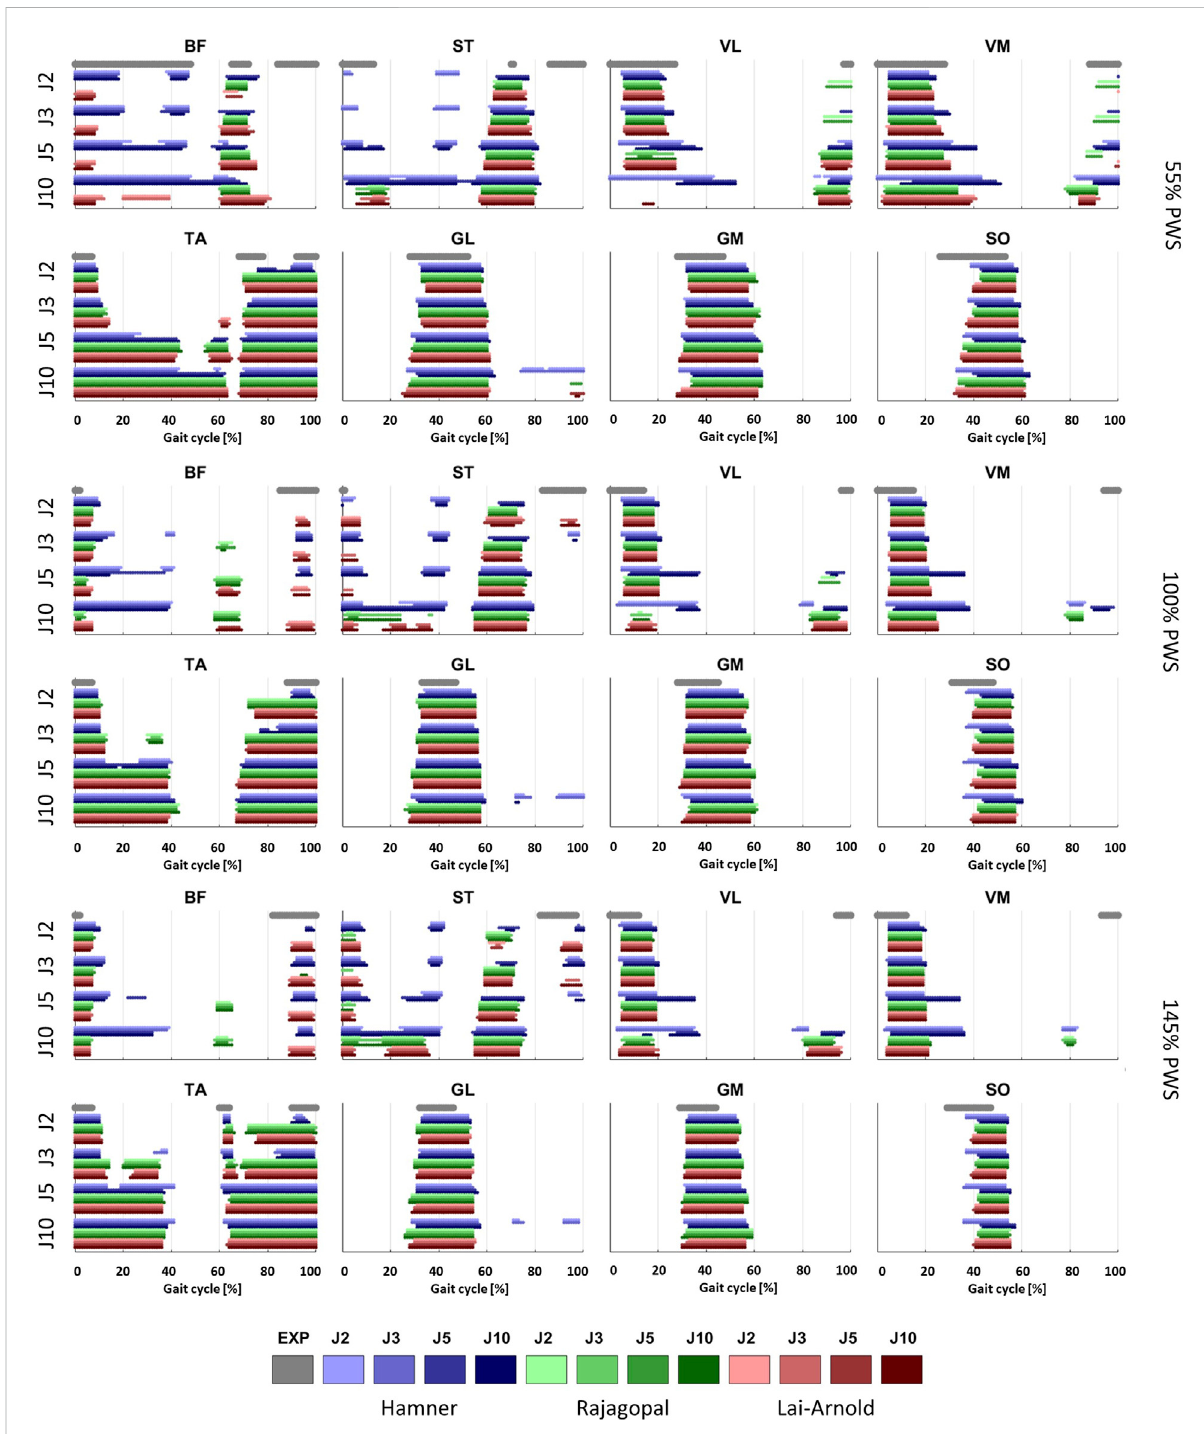
FIGURE 2 On/offtimingofEMGs,averagedoverallsubjects,andestimatedmuscleexcitationsof8musclesat3walkingspeeds,withperformancecriteria based on minimization of muscle effort to the power of 2 (J2), 3 (J3), 5 (J5) and 10 (J10), and scaling variants with linear scaling of OFL and TSL and generic MIF (S1), non-linear scaling of OFL and TSL and generic MIF (S2), linear scaling of OFL and TSL and scaled MIF (S3), and non-linear scaling of OFL and TSL and scaled MIF